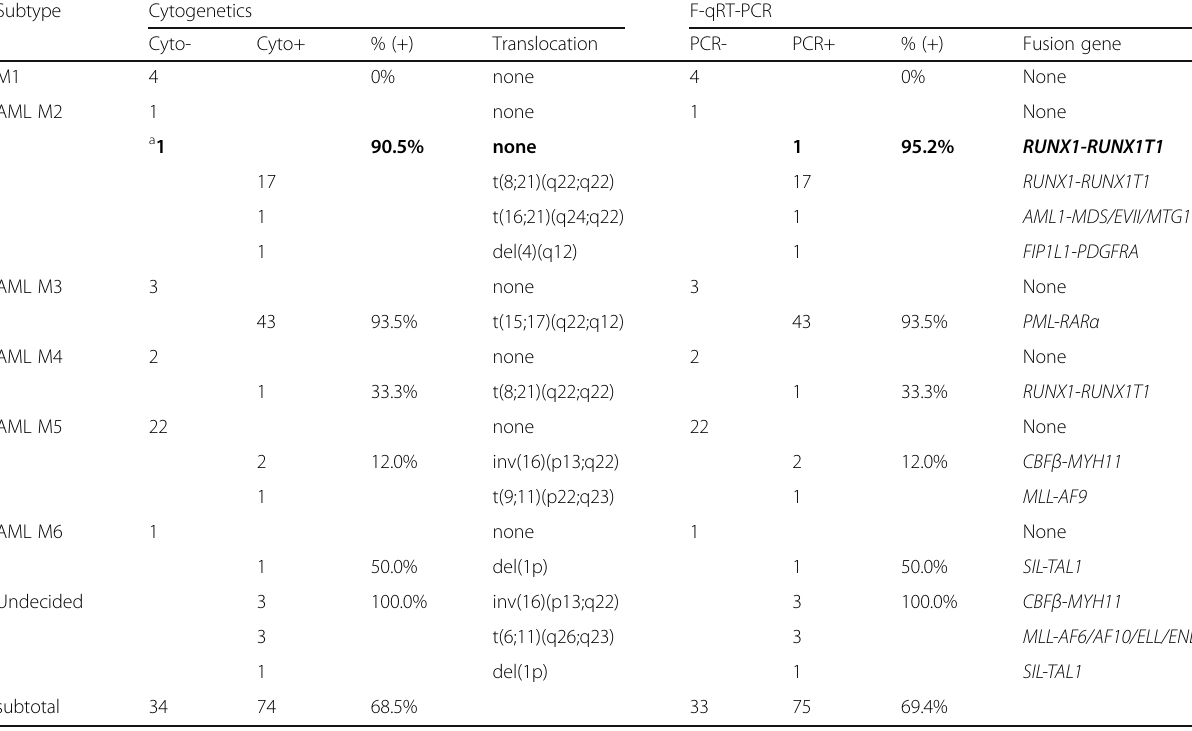
a Bold print indicates cases with inconsistent results obtained using the two diagnostic